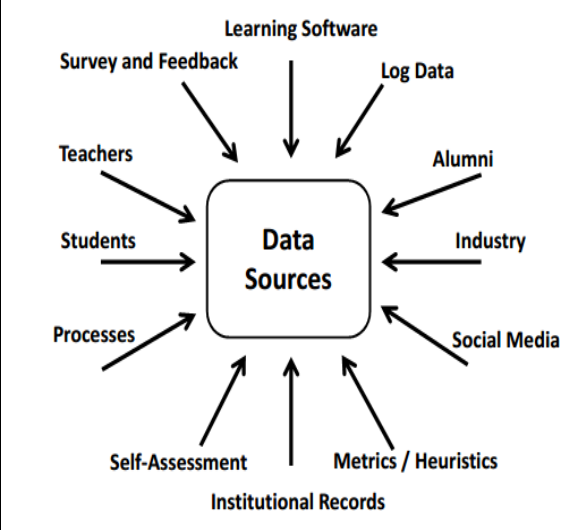
Fig. 2: POTENTIAL SOURCES OF